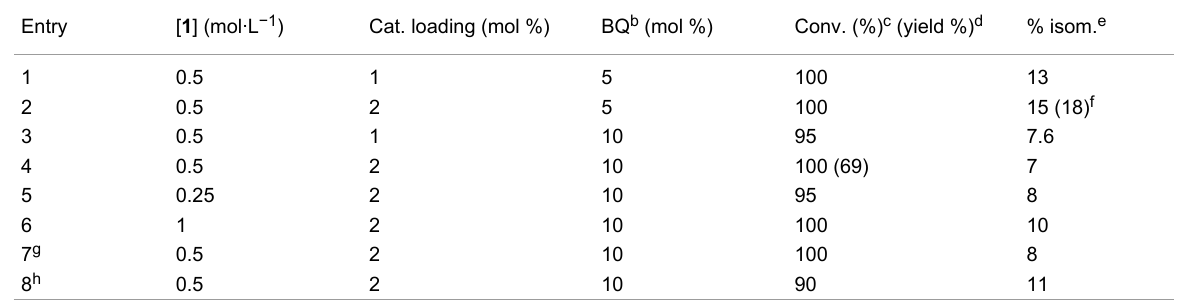
Table 1: Cross metathesis of 1 with methyl acrylate a